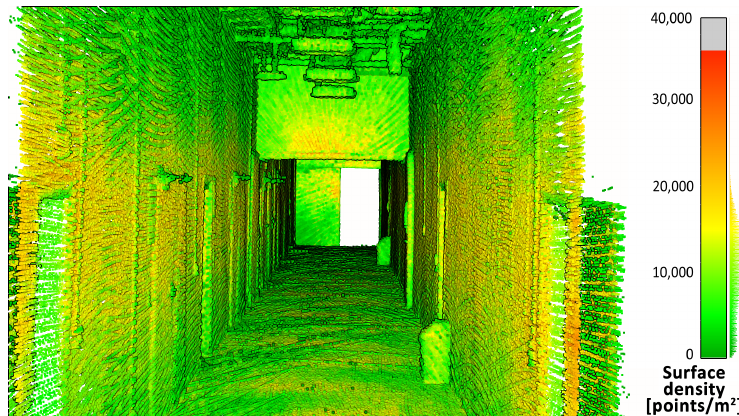
Figure 9. Point cloud density—horizontal lidar.